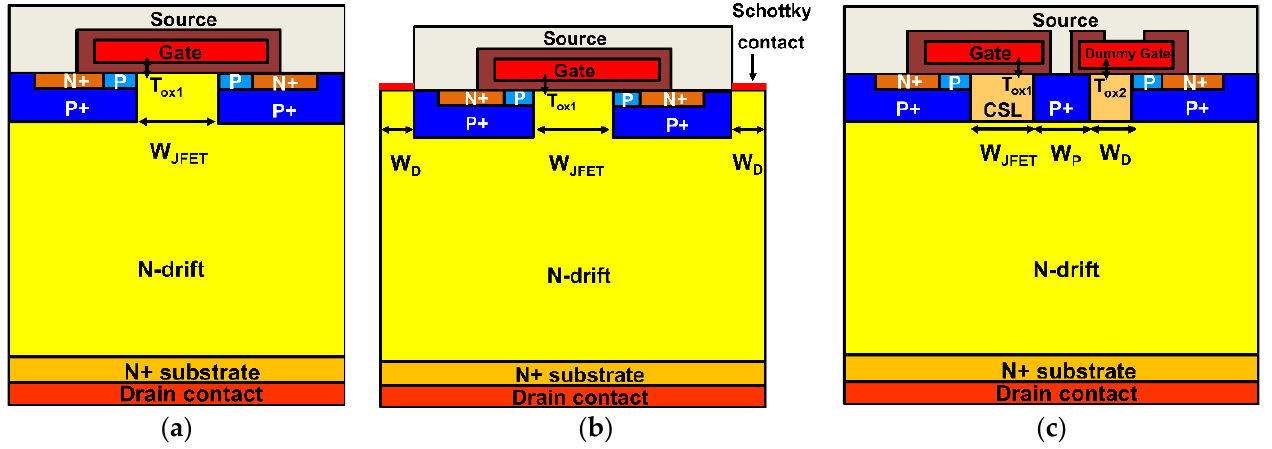
Figure 1. Cross – sectional view of ( a ) C – DMOSFET, ( b ) SBD – MOSFET, and ( c ) CIMCD – MOSFET. Figure 1. Cross–sectional view of ( a ) C–DMOSFET, ( b ) SBD–MOSFET, and ( c ) CIMCD–MOSFET. Table 1. Device